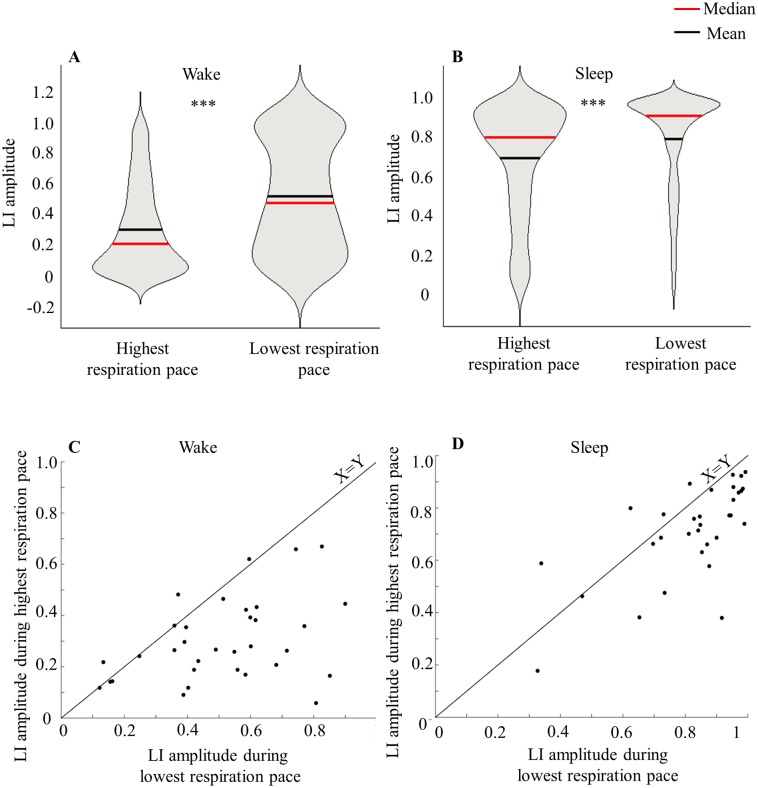
The nasal cycle is linked to overall respiratory frequency.(A) LI amplitude as reflected during highest and lowest respiration pace at wake. (B) LI amplitude as reflected during highest and lowest respiration pace at sleep. Note: We chose violin presentation for A and B panels as it demonstrates not only population mean but also the median and distribution of LI during different respiration conditions. Note that although mean and median values are correct, violin presentation deforms the distribution to be greater than 1, a case clearly not feasible for LI. (C) Comparison of mean LI amplitude during lowest vs highest respiration pace for each subject during wake. (D) Comparison of mean LI amplitude during lowest vs highest respiration pace for each subject during sleep.